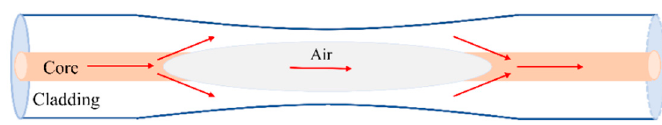
Figure 1. Schematic diagram of the proposed sensing structure.